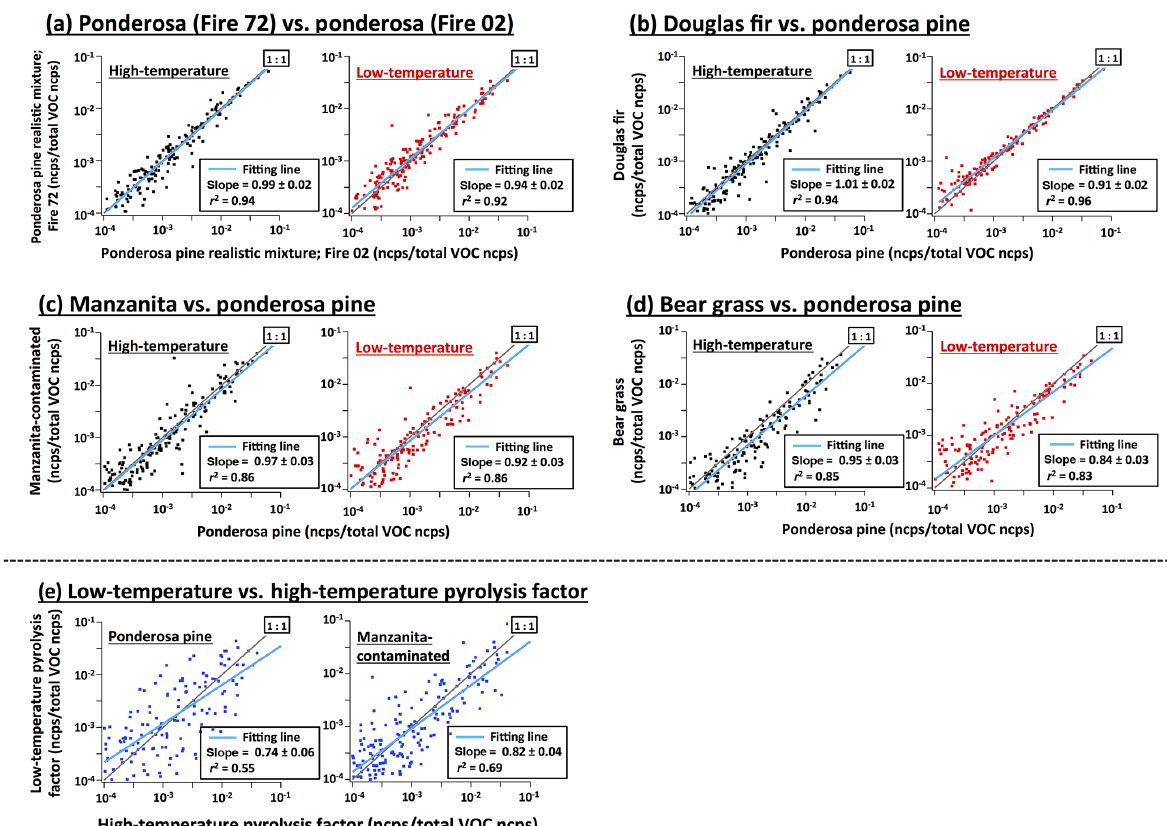
Figure 2. Comparison of mass spectral profiles: (a) ponderosa pine realistic mixture (Fire no. 72) vs. ponderosa pine realistic mixture (Fire no. 02) for high- and low-temperature pyrolysis factors. (In this case, PMF was separately performed for data of Fire no. 02 and no. 72.) (b) Douglas fir vs. ponderosa pine for high- and low-temperature factors. (c) Manzanita (contaminated) vs. ponderosa pine for both the factors. (d) Bear grass vs. ponderosa pine for both the factors. (e) Low- vs. high-temperature pyrolysis factor for ponderosa pine and manzanita (contaminated). Data points in individual panels correspond to well-fitted 434 ion peaks. Slope and correlation coefficient ( r 2 ) are obtained using logarithmic fraction, i.e., log(ncps per total VOC